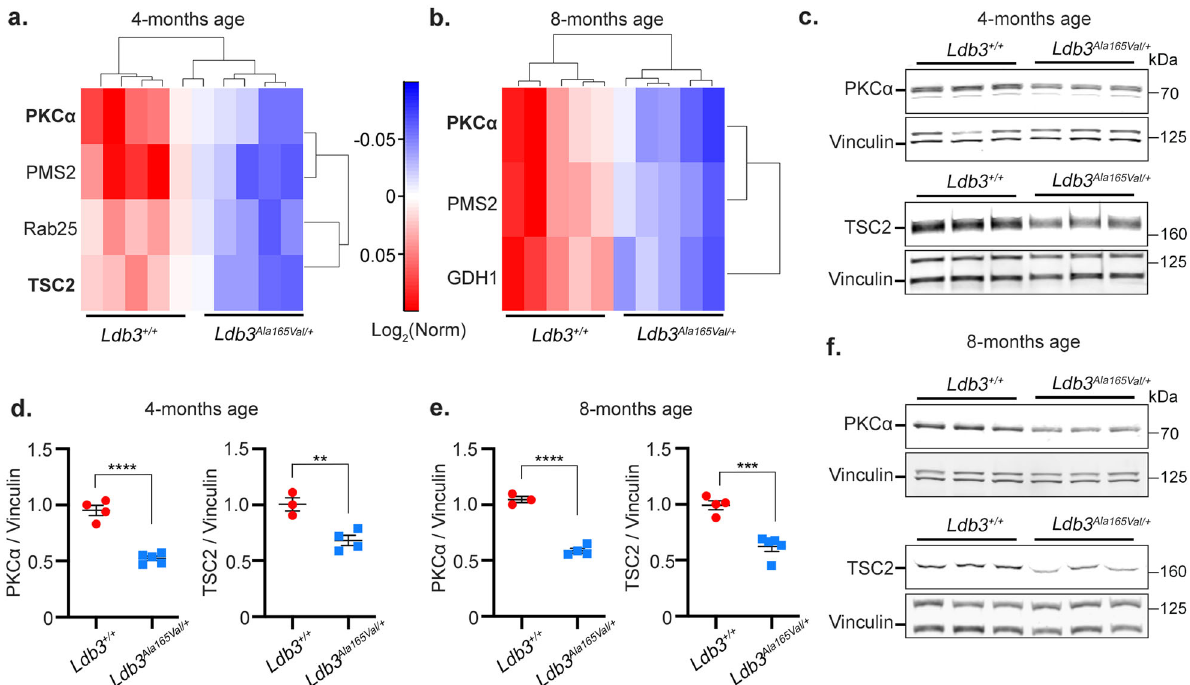
Fig. 6 Effects of LDB3 p.Ala165Val mutation on PKC α and TSC2-mTOR expression in skeletal muscle of Ldb3 Ala165Val/ + mice. Heatmap of protein levels in the vastus muscle lysates of 4 months ( a ) and 8-month-old ( b ) Ldb3 Ala165Val/ + mice and their gender-matched Ldb3 + / + littermates ( n = 5 per group; total 20 mice) detected by RPPA. Differentially expressed proteins with statistically signi fi cant fold changes are shown on the vertical axis ( ≥ 1.5- fold, corrected p ≤ 0.05). The levels of each protein are presented with colors, with blue for lowest and red for highest. See Supplementary Table 2. Only PKC α and TSC2 are known to localize at skeletal muscle Z-disc. c , d Immunoblotting analysis (blot and dot plot) of PKC α and TSC2 protein levels relative to vinculin in the vastus muscle of 4-month-old Ldb3 Ala165Val/ + mice ( n = 5 and 4, respectively) and Ldb3 + / + littermates ( n = 4 and 3, respectively). e , f Immunoblotting analysis (blot and dot plot) for protein levels of PKC α and TSC2 relative to vinculin in the vastus muscle of 8-month-old Ldb3 Ala165Val/ + mice ( n = 4 and 5, respectively) and Ldb3 + / + littermates ( n = 3 and 4, respectively). The error bars in dot plots are Mean (SEM) and represent triplicate assays. The two-tailed unpaired t -test comparison signi fi cant p values are shown. ** p < 0.01; *** p < 0.001; **** p <